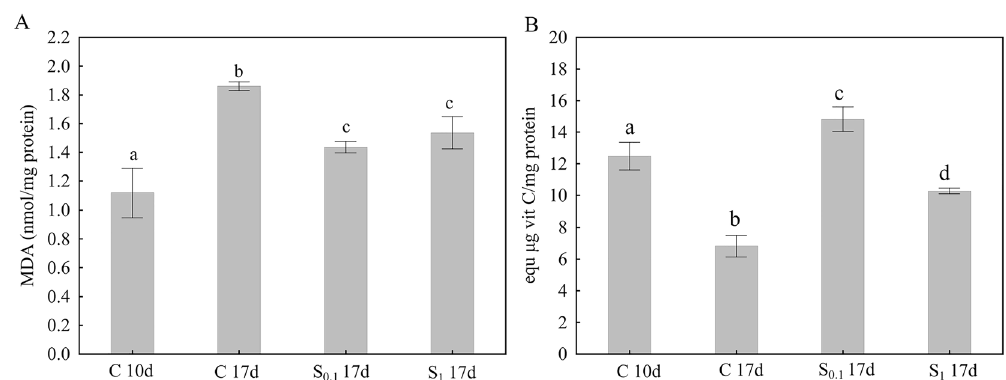
Figure 5. MDA level (nmol/mg) ( A ) and FRAP (equ µg vit C/mg protein) ( B ) after 10 (10d) and 17 days (17d) in honey bee. Control C was fed with 50% sucrose solution, and in groups S 0.1 and S 1 diet was supplemented with 0.1 mM and 1 mM spermidine, respectively. Data is presented as mean ± standard error (SE). Differences between mean values were analyzed with one-way ANOVA and post-hoc Duncan’s test. Different letters indicate differences among all experimental groups shown on the graph for p <